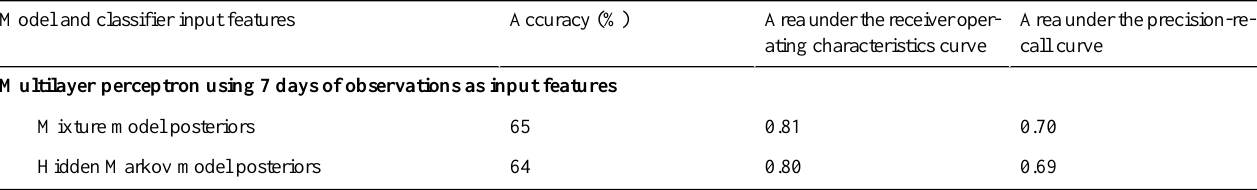
Area under the precision-re-